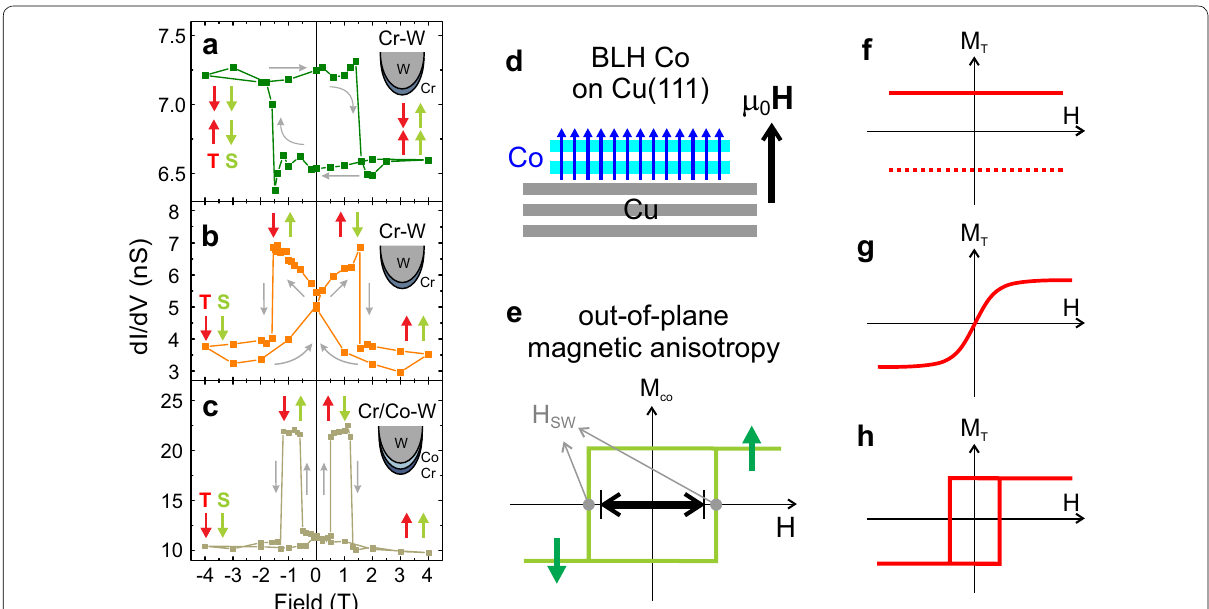
Fig. 4 Magnetic response of tips in spin‑STM. a – c d I /d V magnetic hysteresis loops measured on bilayer Co islands, with 3 different tips as denoted at the top ‑ left corner of each figure. The black arrows show the field sweep directions for data acquisition. The red and green arrows represent the magnetization directions of tip and sample, respectively, at field values for d I /d V signal saturation. For the loop in a, a fixed tip magnetization direc‑ tion is expected, however, its direction cannot be decided and the two possibilities are shown. d , e Schematics for local magnetic moments ( d ) and magnetization hysteretic response ( e ) of a bilayer Co island on Cu(111). f – h Field response of the tip magnetization extracted from the d I /d V hysteresis loops shown in a – c , respectively, in regard to the magnetic response of the Co island described in e (Reprinted from [25] with permission from American Institute of Physics (Copyright